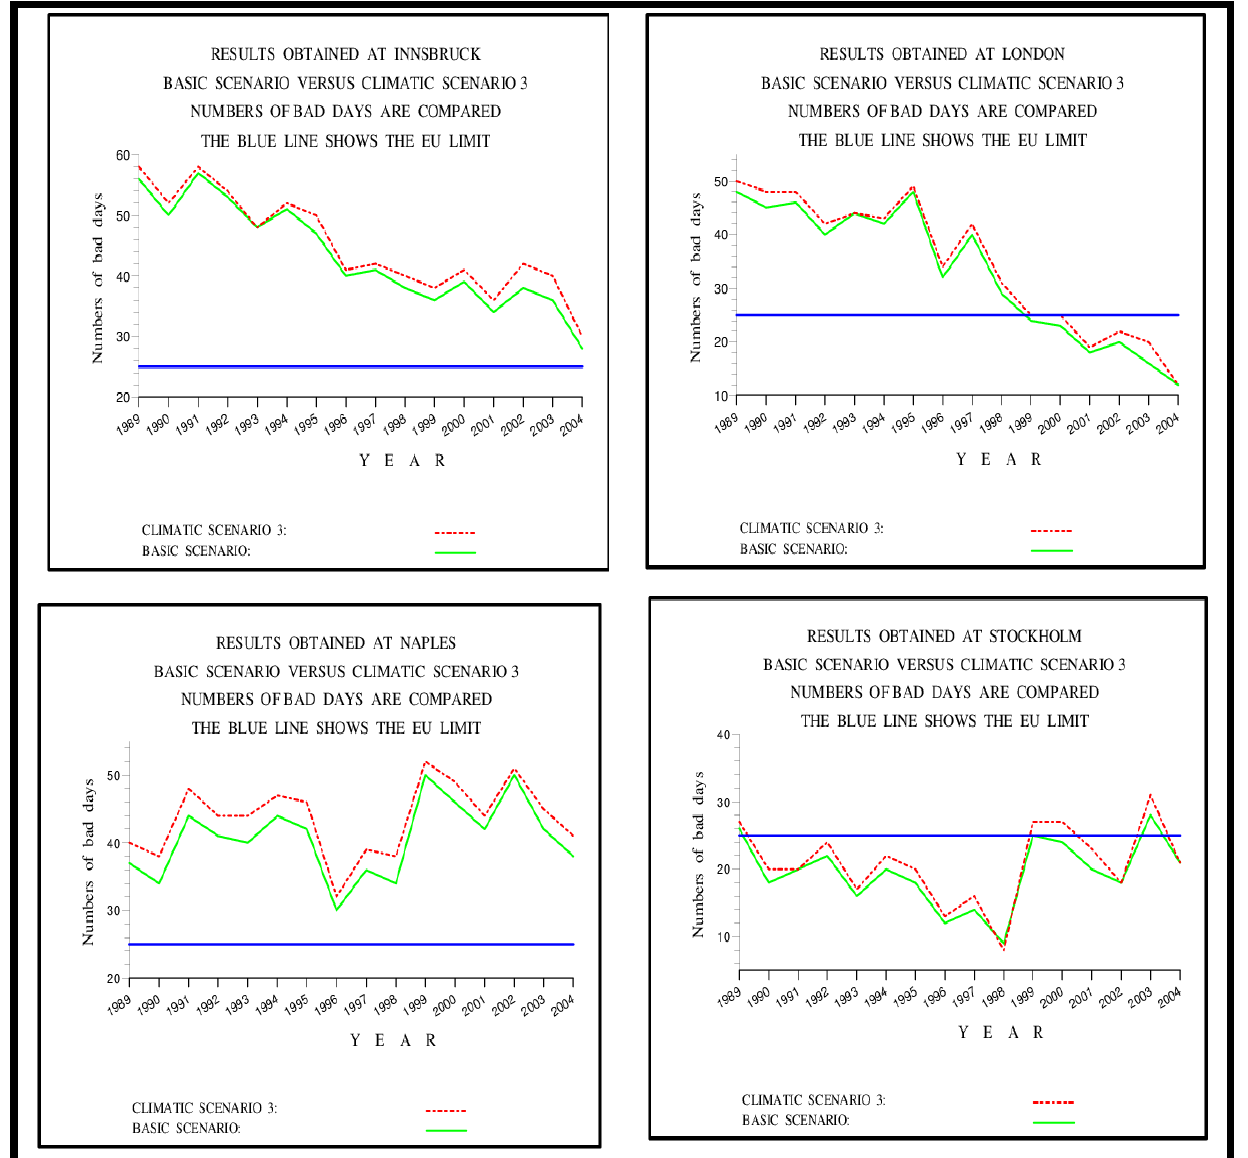
Figure 4. Variations of the numbers of “bad days” in Innsbruck, Naples, London and Stockholm during a time-period of 16 consecutive years obtained when UNI-DEM is run with two scenarios. It is clear that the Third Climatic Scenario is consistently given more “bad days” than the Basic